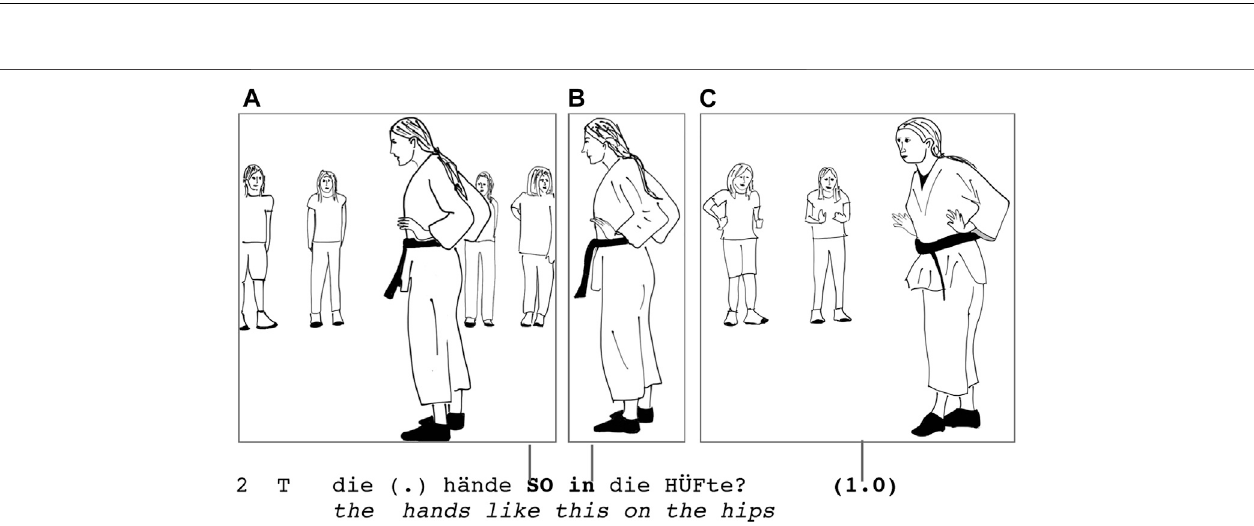
FIGURE 7 | Gesture strokes and gaze shift back to addressees.